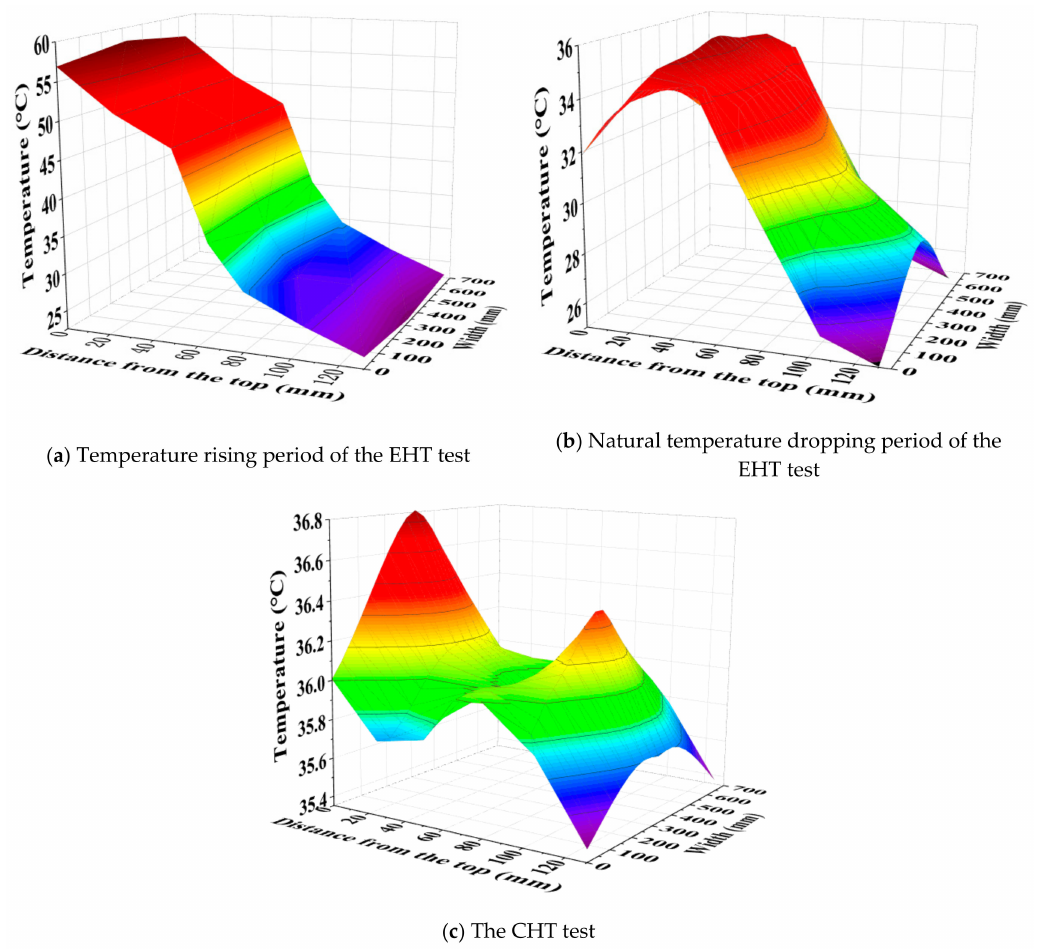
Figure 11. 3D temperature distribution in the